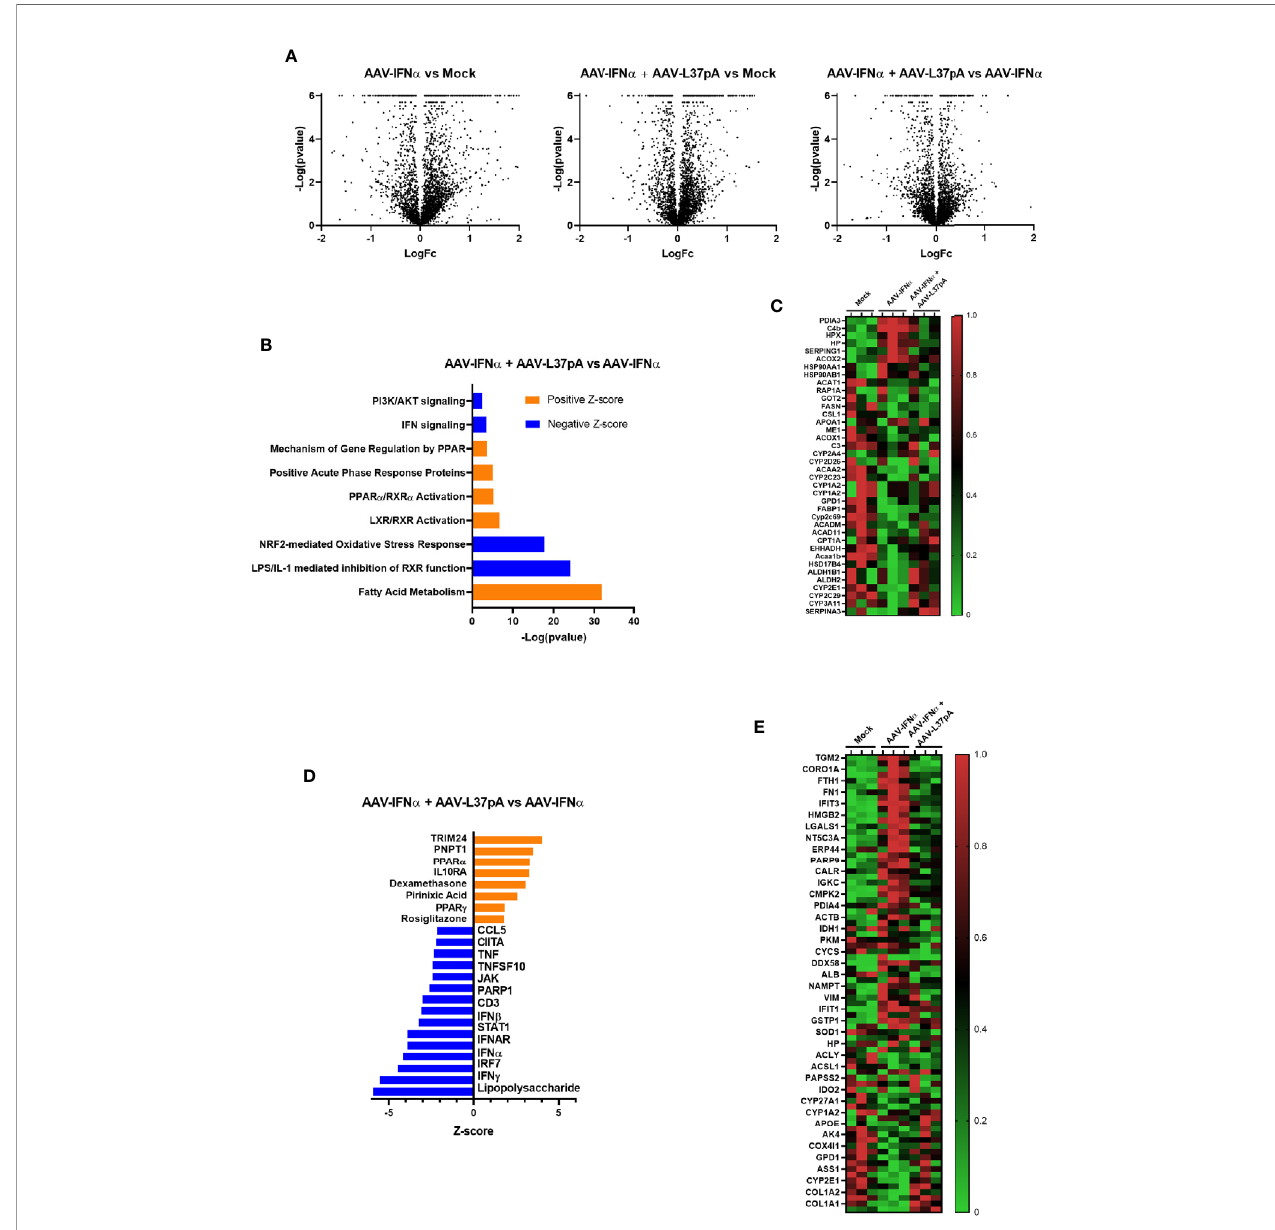
FIGURE 4 | Long-term expression of L37pA modi fi es the AAV-IFN a effect in the liver at the protein level. Total proteins were isolated from the liver as described in Figure 2A and proteomic analysis was performed. (A) Volcano plot of proteins different levels in the liver of mice untreated (Mock), treated with AAV-IFN a or AAV- IFN a and AAV-L37pA. (B) Top signi fi cantly affected pathways based on Ingenuity pathway analysis (IPA). The horizontal bars denote the different pathways based on the z-score. Orange color indicates upregulation, while blue color indicates downregulation. (C) Heat map representing the relative protein levels contributing to the top signi fi cantly affected pathways. (D) Top signi fi cantly affected upstream regulators based on Ingenuity pathway analysis (IPA). The horizontal bars denote the different pathways based on the Z-score. Orange color indicates upregulation, while blue color indicates downregulation. (E) Heat map representing the relative protein levels contributing to the top signi fi cantly affected upstream